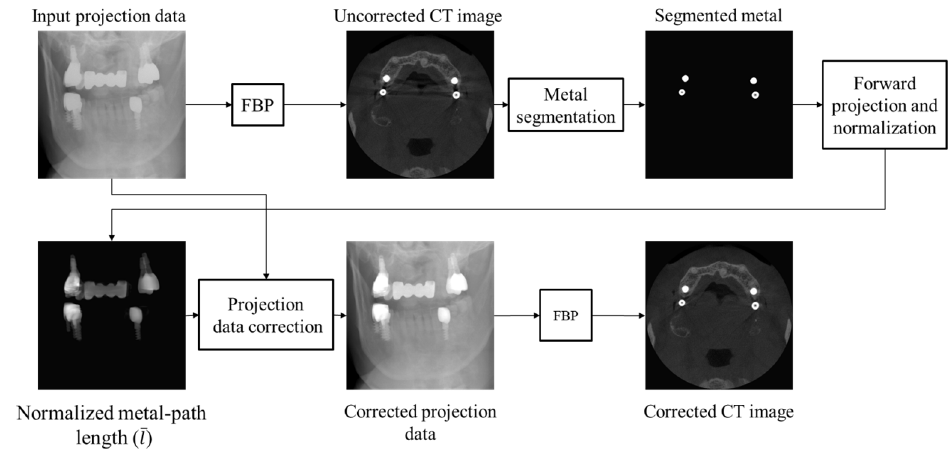
Figure 5. The workflow of the proposed metal artifact reduction method.